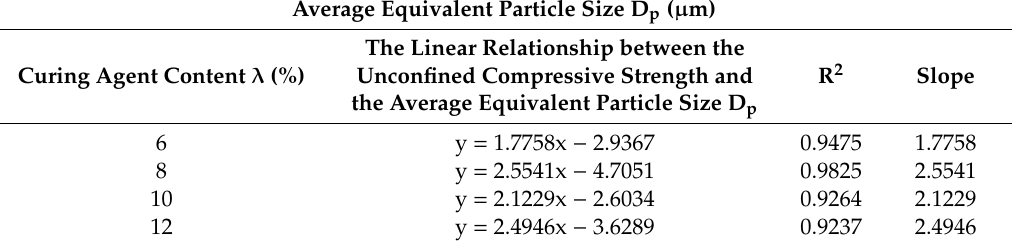
Table 10. Linear dependence of the unconfined compressive strength and the average equivalent particle size.